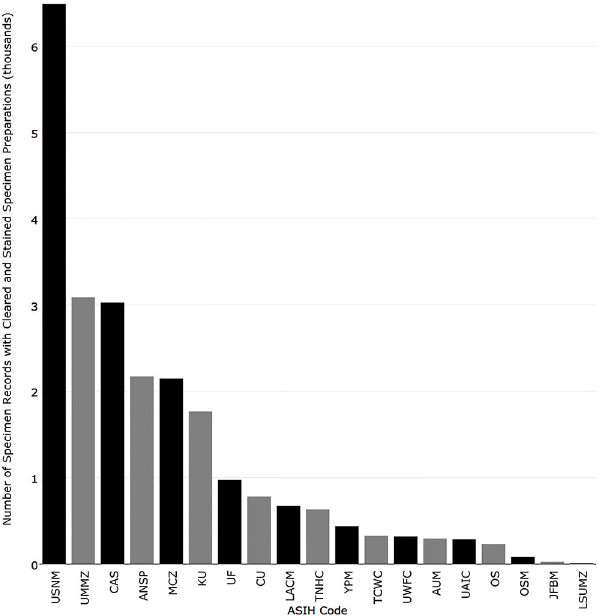
Fig 13. Number of records published in iDigBio with at least one cleared and stained specimen